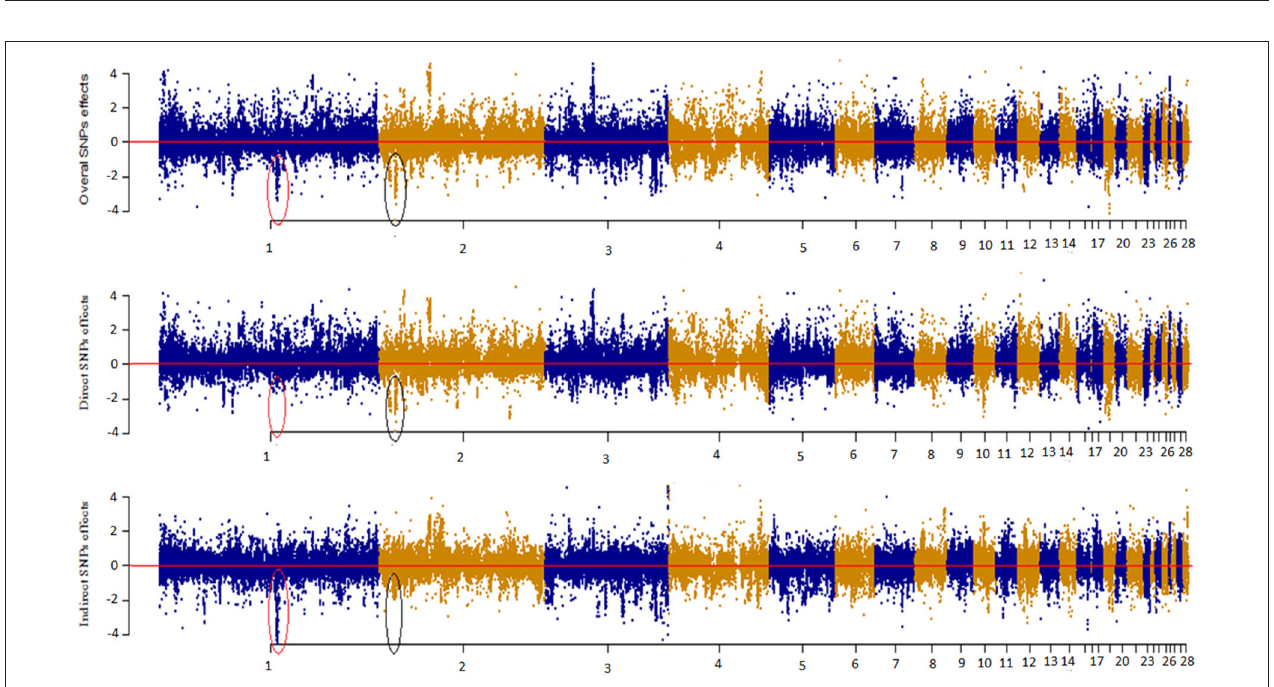
FIGURE 4 | Manhattan plot showing overall, direct and indirect SNP effects using a full recursive model based on A matrix for body weight (BW).